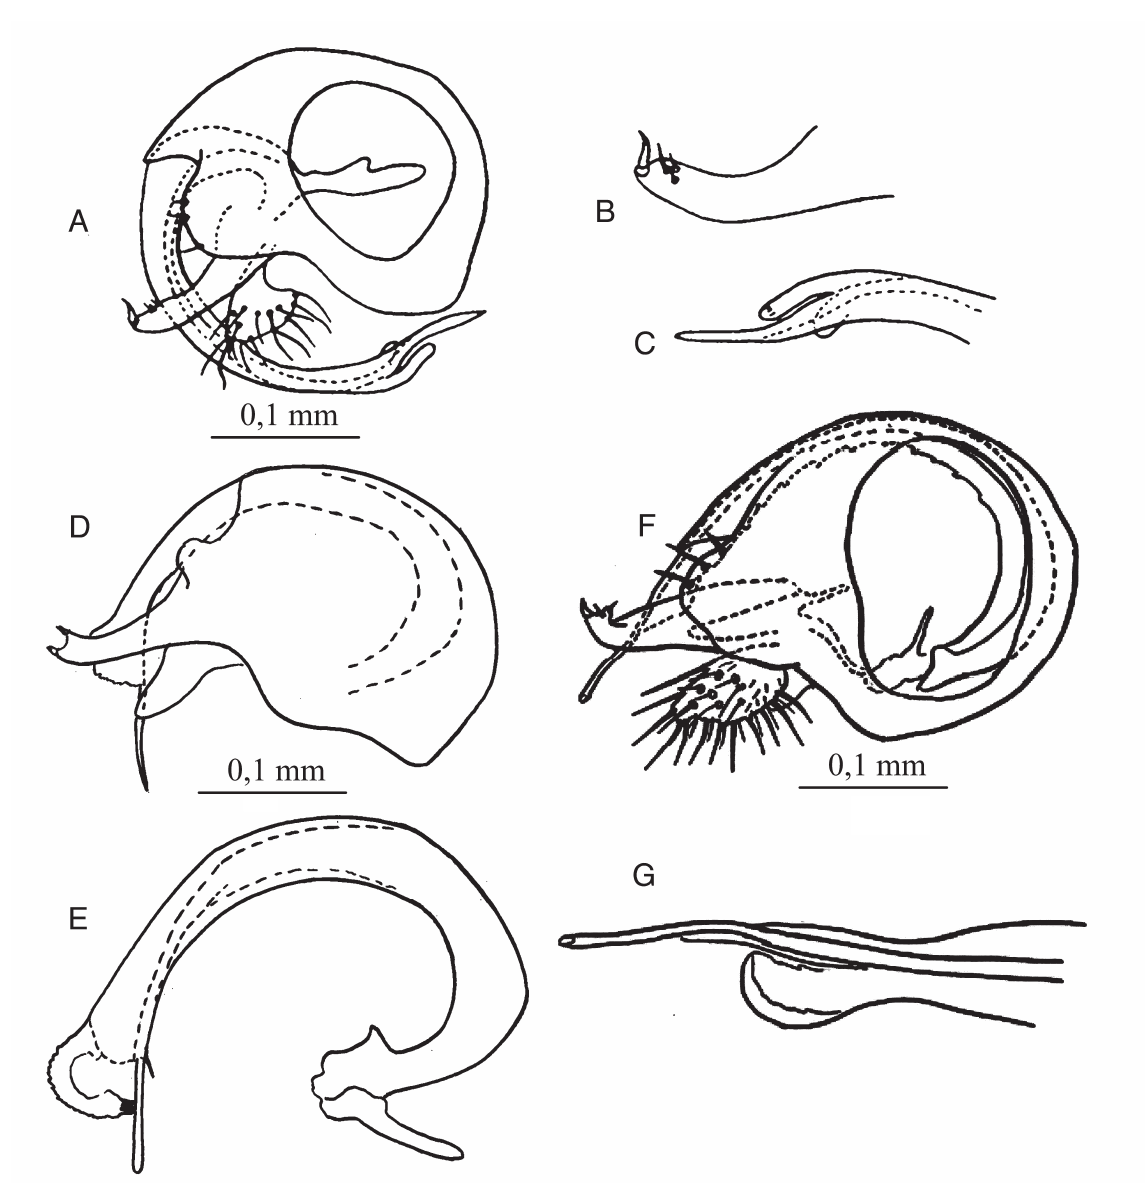
Fig. 3. A – C . Chrysotus nudisetus Negrobov & Maslova, 1995, ♂, paratype, Russia (Sakhalin). A . Hypopygium, lateral view. B . Surstylus, ventral view. C . Apex of phallus, lateral view.